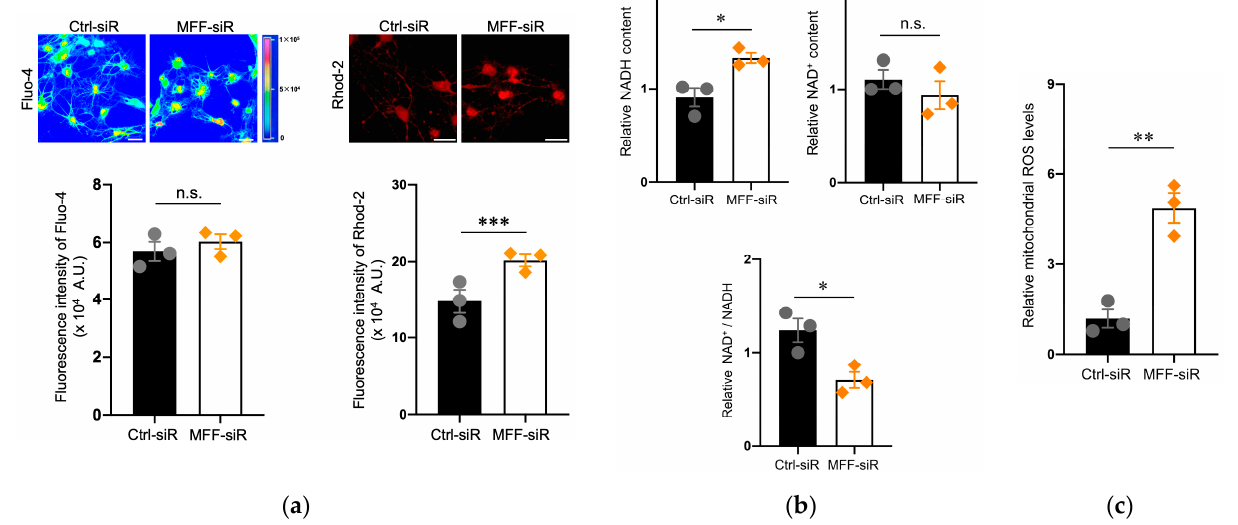
Figure 2. MFF insufficiency induced mitochondrial Ca 2+ and ROS accumulation in DNs. ( a ) DNs stained with Fluo-4 AM (to detect cellular Ca 2+ ) and Rhod-2 AM (to detect mitochondrial Ca 2+ ) were observed by confocal microscopy. Scale bars = 25 μ m. Fluorescence intensity of Fluo-4 AM and Rhod-2 AM were measured using a plate reader. The mean ± SEM was taken from three independent experiments. n.s., not significant, *** p < 0.001. ( b ) Relative levels of intracellular NADH, NAD + , and NAD + /NADH in each case. The mean ± SEM was taken from three independent experiments. n.s., not significant, * p < 0.05. ( c ) Mitochondrial ROS levels were measured using flow cytometry. The mean ± SEM was taken from three independent experiments. ** p < 0.01.